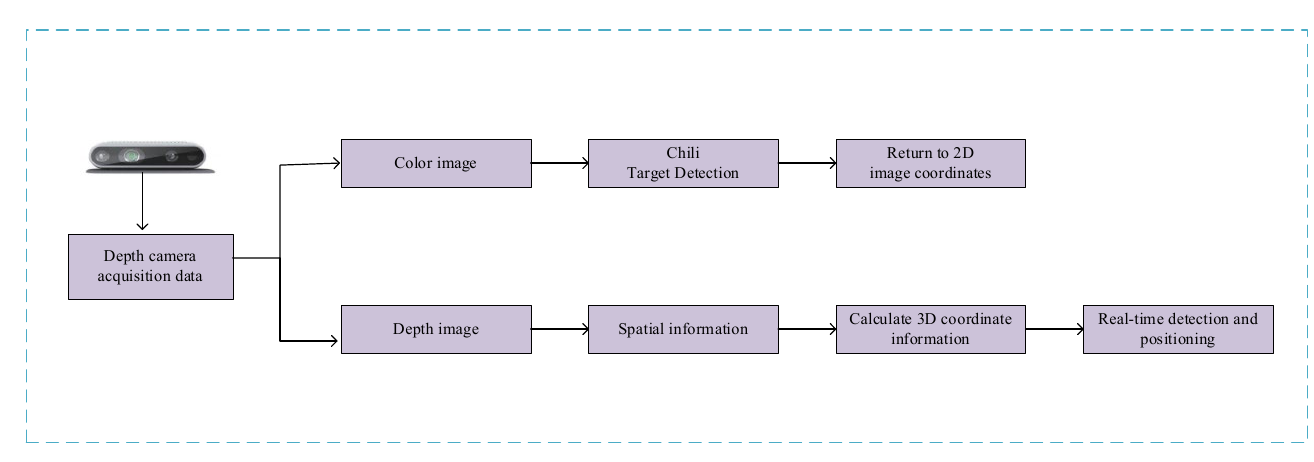
Figure 16. Real time recognition model. Table 4. 3D locating of chili fruits.